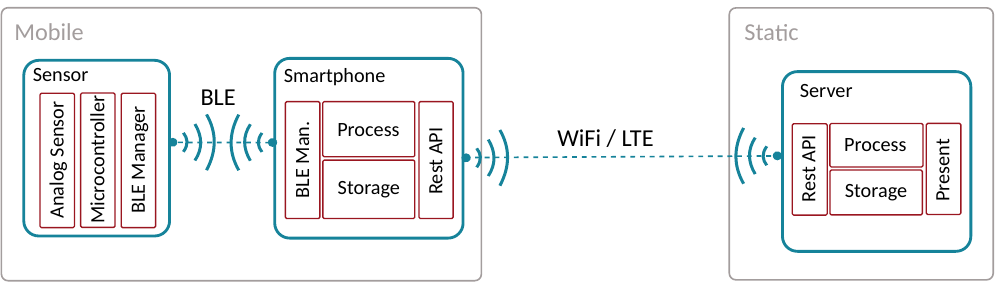
Figure 8. Crowdsensing architecture overview.